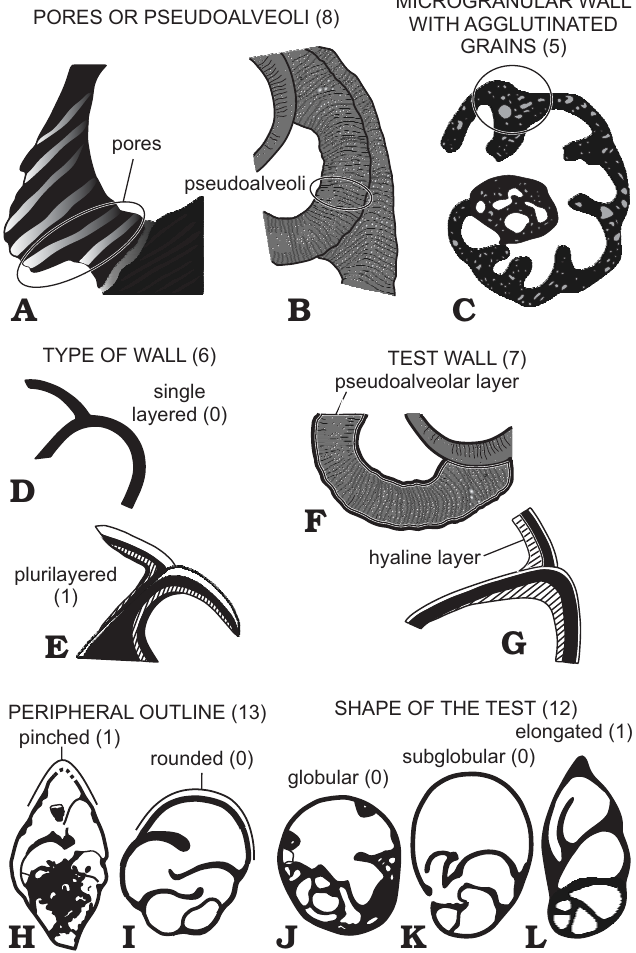
Fig. 2. Graphic explanation of descriptive morphological characters on which the cladistic analysis is based. A . Danielita gailloti Alt ı ner